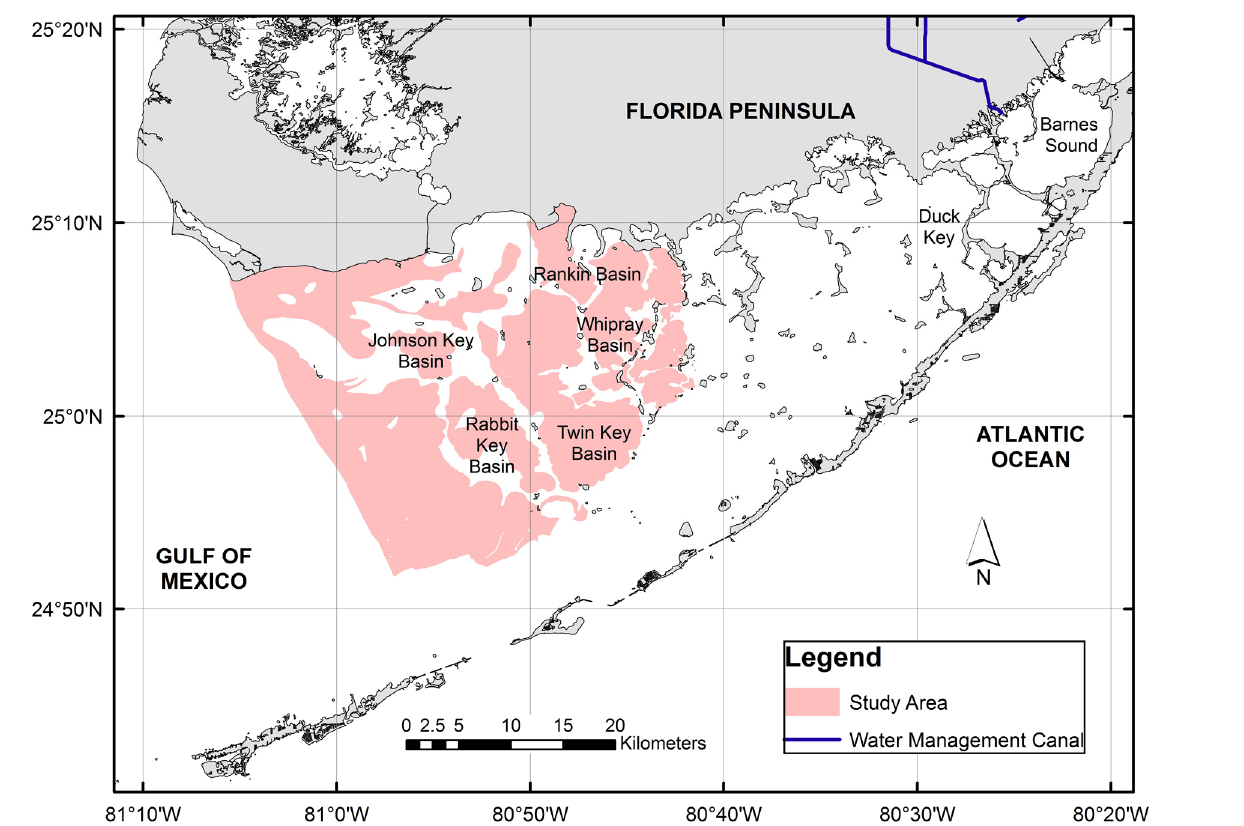
Figure 2. Map overview of Florida Bay and the study area. Field data on seagrass abundance were obtained for labeled